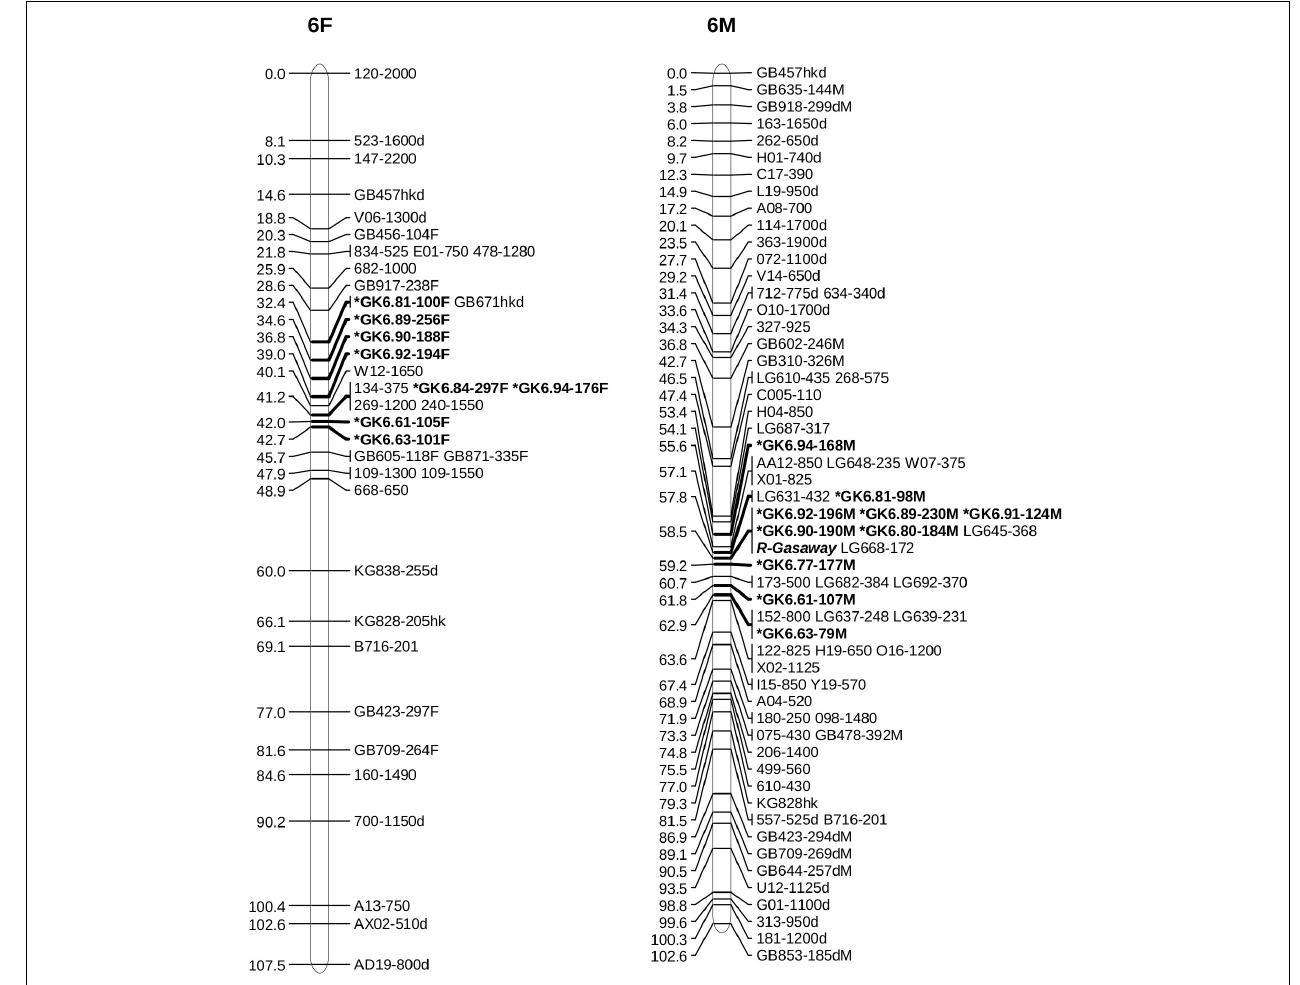
FIGURE 2 | Maps of linkage group 6 (LG6) of female parent OSU 252.146 (left) and resistant parent OSU 414.062 (right) in the reference mapping population for hazelnut ( Corylus avellana ) with new simple sequence repeat markers indicated by *. Units are centimorgans